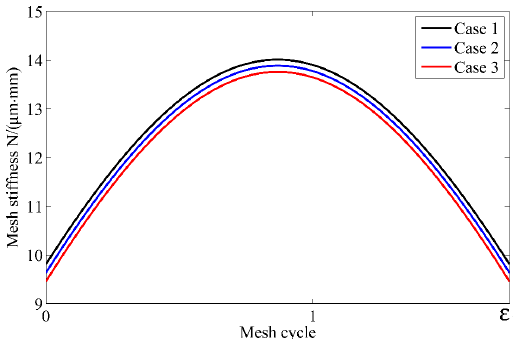
Figure 3. The single-tooth-pair mesh stiffness. Appl. Sci. 2018 , 8 , 2404